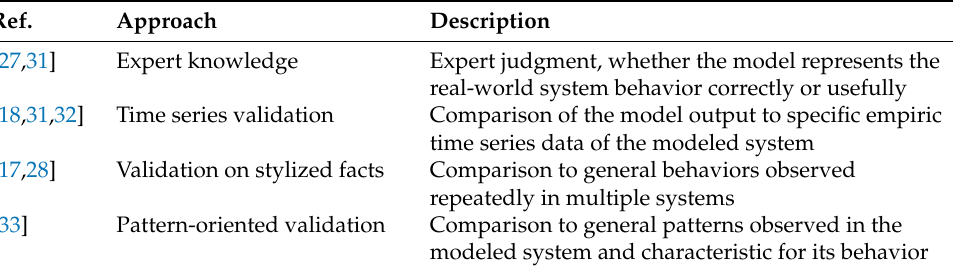
Table 3. Approaches to the validation of agent-based models in various scientific disciplines.